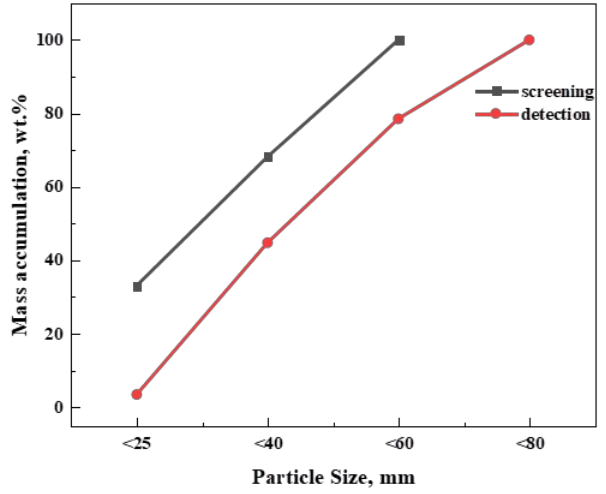
Figure 14. YOLOv3 model detection and screen size cumulative curve.